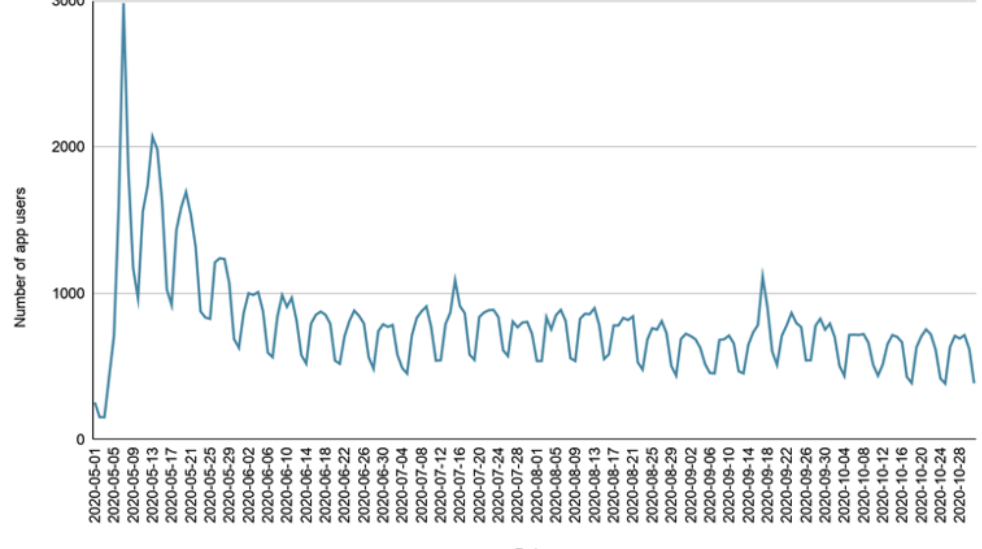
Table 1. Overall key content usage among all COVID Coach users within the observation window (between May 1, 2020, and October 31, 2020).